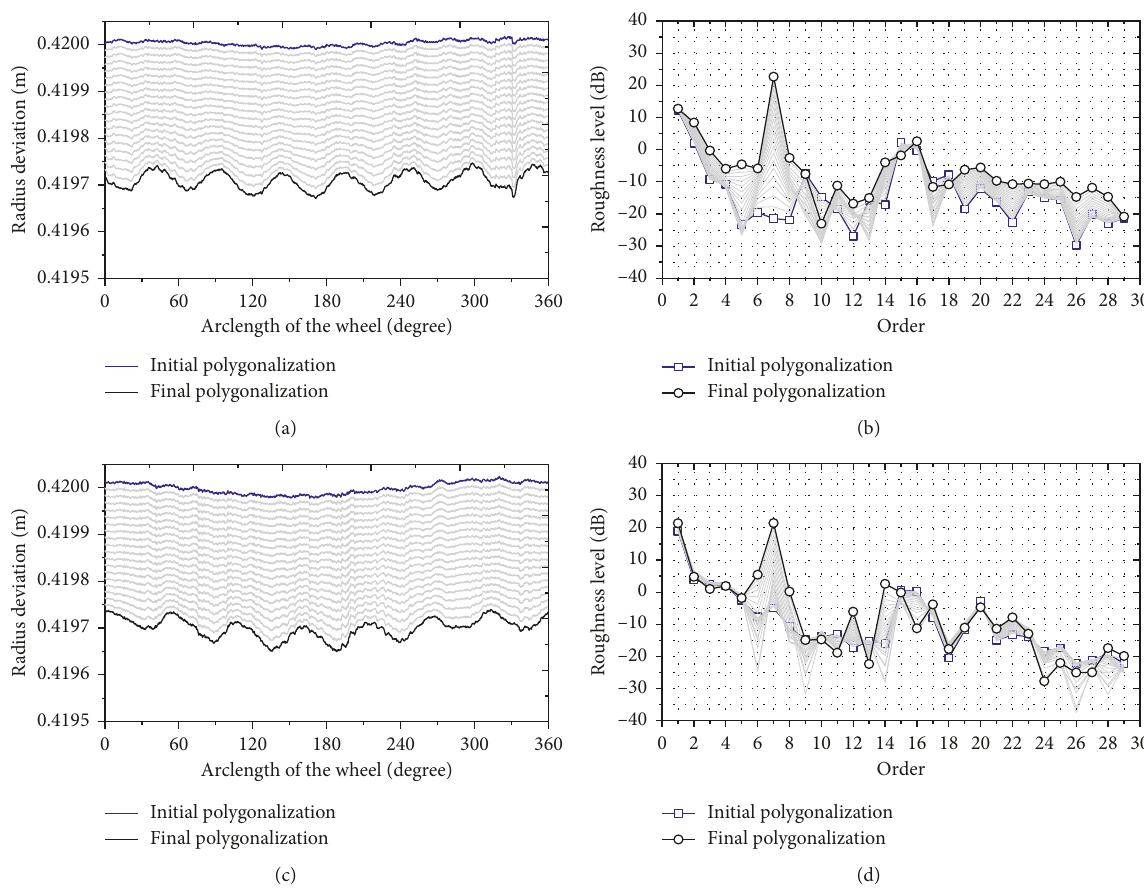
Figure 15: Evolution of wheel polygonalization based on the initial measured wheel irregularity, development of radius deviation, and harmonic-order levels (for a vehicle running at a speed of 75km/h for 22,000km): (a, b) leading wheel; (c, d) trailing wheel.